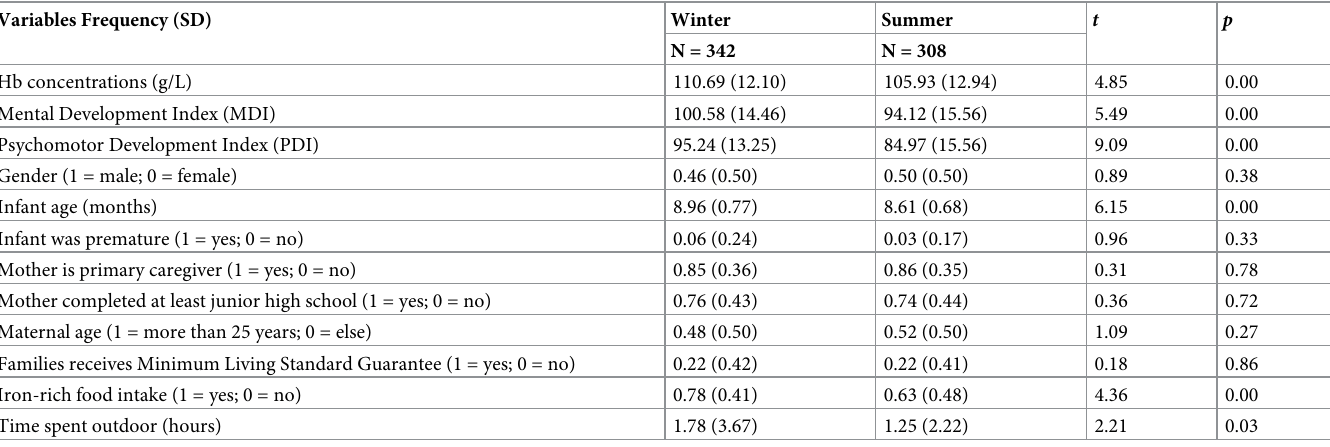
Table 3. A comparison between the winter and summer groups: demographic and development status and caregiver behavior (N = 650). Variables Frequency